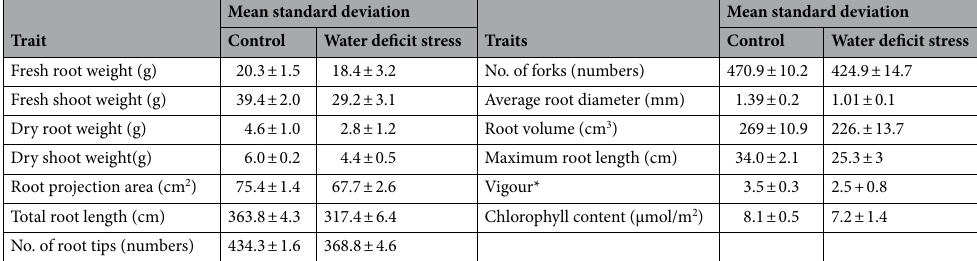
Table 1. Descriptive statistics for seedling traits of 71 inbred lines under well-watered (control) and water deficit stress (WDS) conditions. g fresh and dry root weight; shoot weight, cm 2 root projection area, cm maximum and total root length (covering all root branches), cm 3 root volume, µmol/m 2 Chlorophyll content, number includes all root tips, hairs and forks (extending from main branch as seminals), mm average root diameter () indicate unit of respective trait. *Vigour (0–4 scale): 0 (representing dead), 1 (very poor), 2 (poor health), 3 (reduced vigour but with browning of leaf tips) 4 (deep green leaves with no wilting or chlorosis: high vigour).